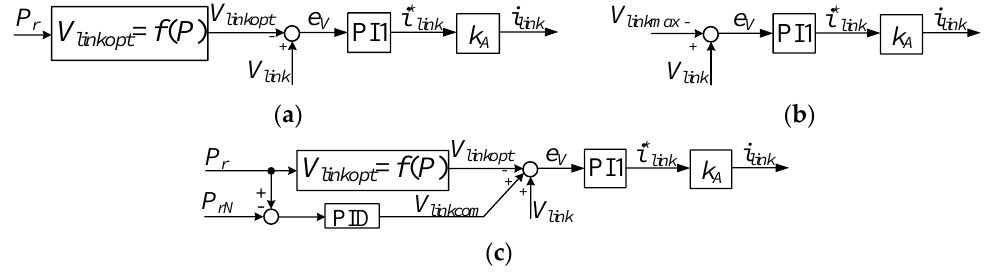
Figure 6. Simplified control block diagram. ( a ) Maximum power point tracking (MPPT) operation mode; ( b ) constant speed (CS) operation mode; ( c ) constant power (CP) operation mode.